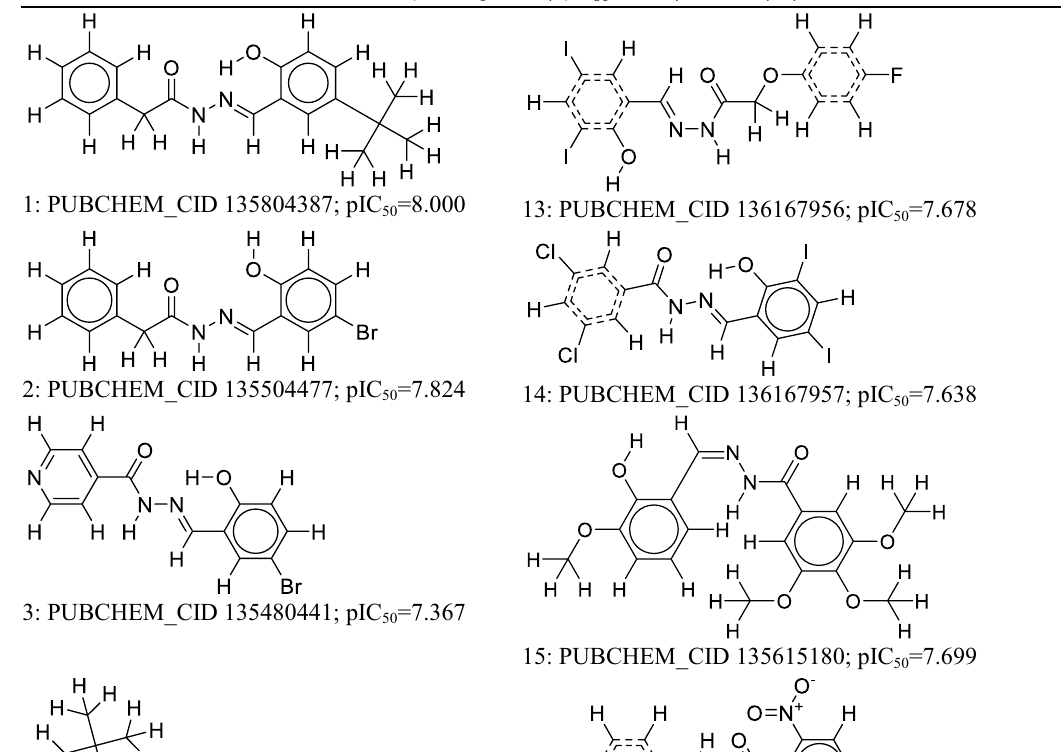
Table 1 PubChem_CID number and corresponding activity pIC